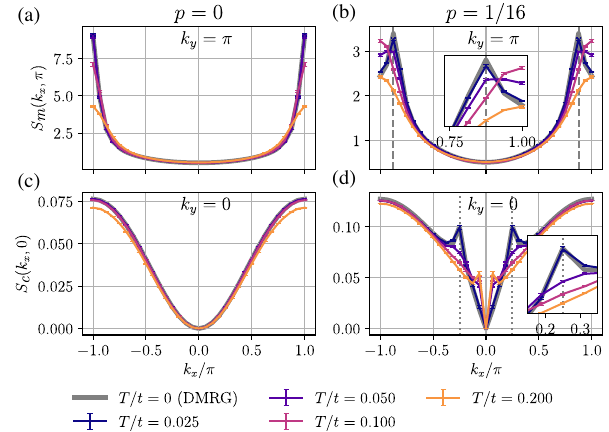
FIG. 2. Magnetic and charge structure factors S m ð k Þ and S c ð k Þ of the 32 × 4 square cylinder at U=t ¼ 10 for p ¼ 0 (left) and p ¼ 1 = 16 (right). We compare different temperatures from 2000 and ground-state DMRG with METTS with D max ¼ D 5000 . (a) Magnetic structure factor for p ¼ 0 and max ¼ k π . The peak at k ¼ ð π ; π Þ indicates the antiferromagnetism. y ¼ (b) Magnetic structure factor for p ¼ 1 = 16 and k y ¼ π . The peak at k ¼ ð 7 π = 8 ; π Þ (gray dashed line) indicates the stripe order illustrated in Fig. 1(a). (c) Charge structure factor for p ¼ 0 and k 0 . The quadratic behavior at k 0 indicates a gap to y ¼ x ¼ charged excitations. (d) Charge structure factor for p ¼ 1 = 16 and k 0 . We observe a peak at k ¼ ð π = 4 ; 0 Þ (gray dotted line). y ¼ This indicates a half-filled stripe phase at low temperatures. The approximately linear behavior at k x ¼ 0 indicates a small or vanishing charge gap. In all cases, we find the METTS